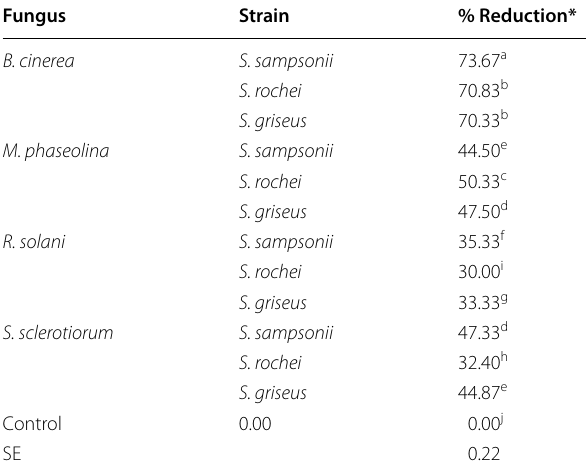
*Values with the same letter, in the column, are not significantly different ( P 0.05)